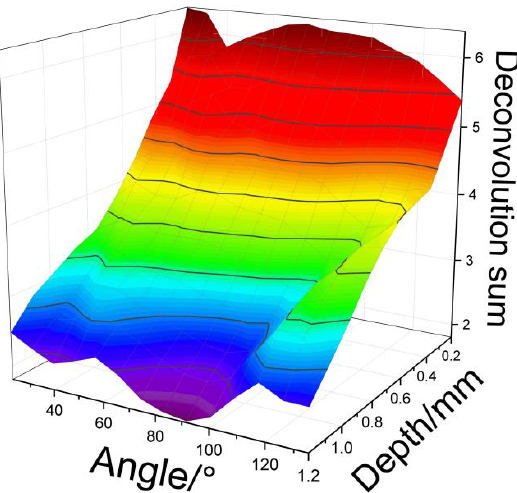
Figure 11. 3D map of depth and angle versus deconvolution sum. In the time–frequency domain, WP coefficient peaks, WP energy peaks, and WP entropy are extracted and analyzed in this paper. Taking the transmitted wave as an example, the WP coefficient peaks, WP energy peaks, and WP entropy of transmitted waves at different crack depths and oblique angles are shown in Figure 12.